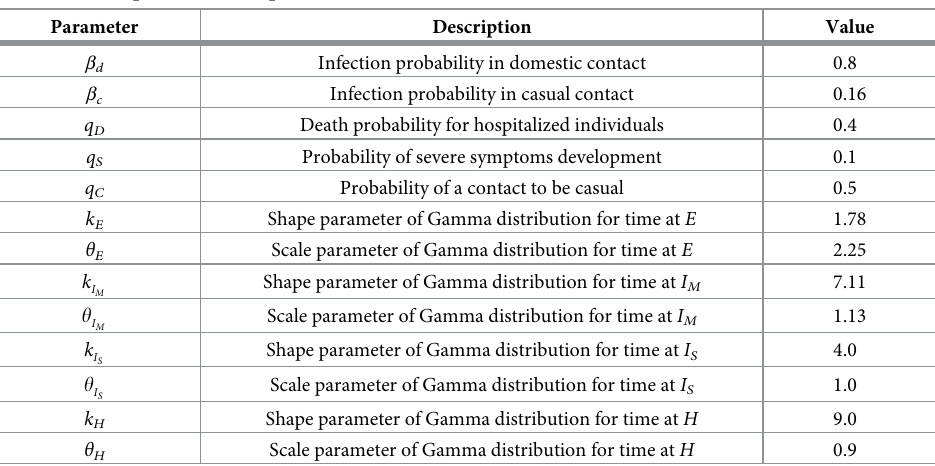
Table 1. Default parameters for